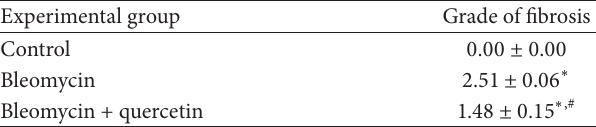
Table 4: Szapiel examination scores of lung tissue from rats subjected to various treatments.